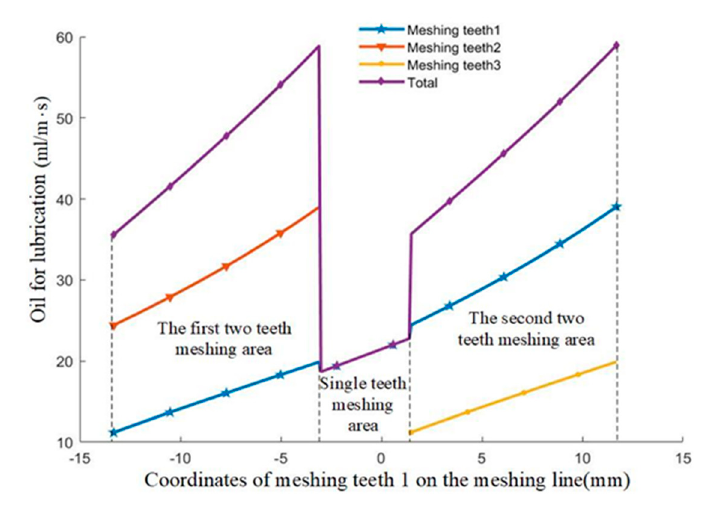
Figure 3. Oil volume for lubrication during the meshing process.